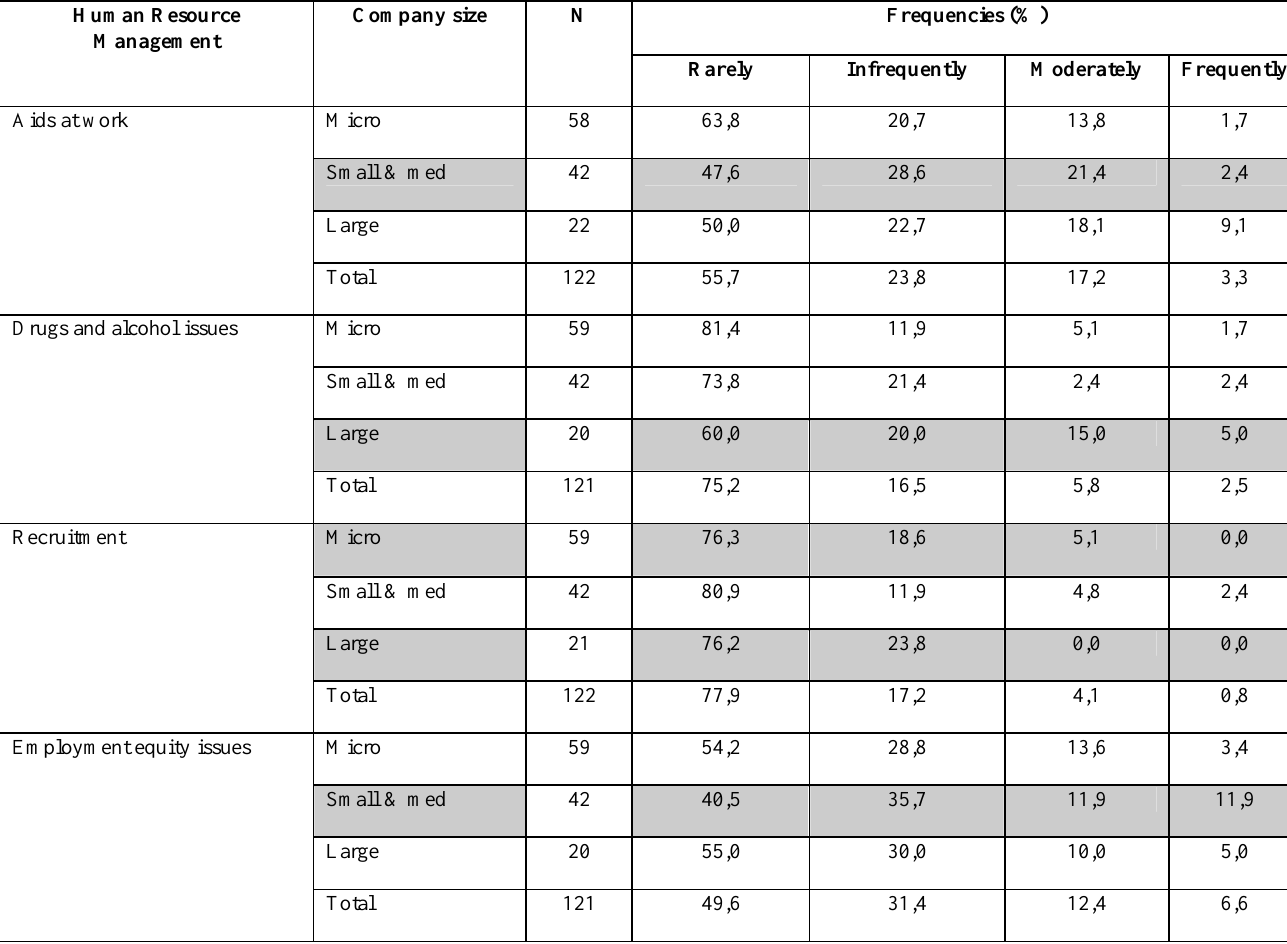
Table 5: Comparison between company size and responses to human resource management Human